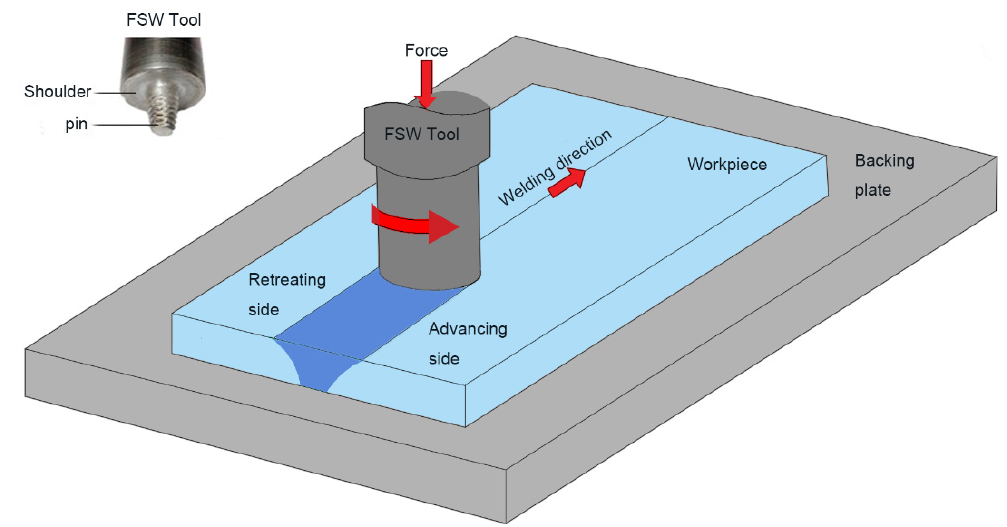
Figure 1. Illustration of friction stir welding (FSW) process.